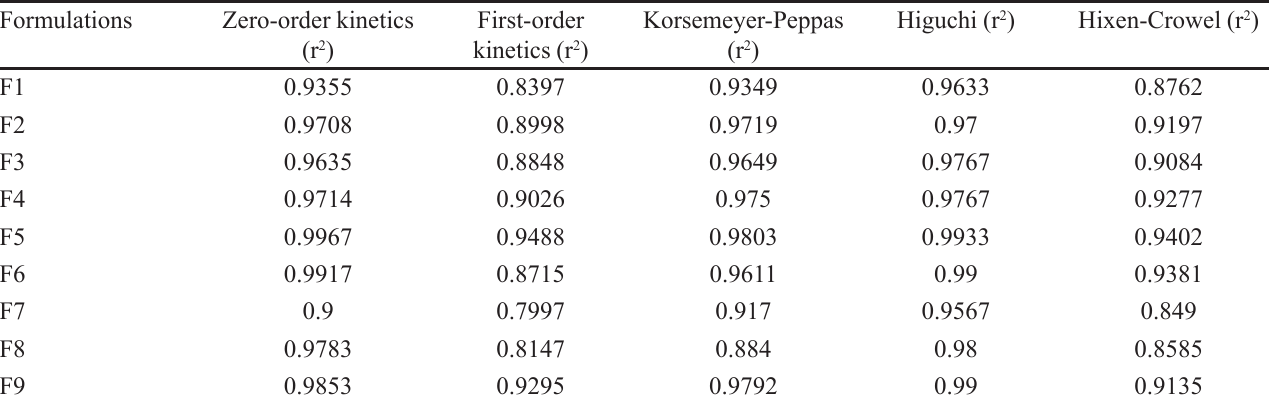
TABLE VI - Kinetic models showing drug release pattern of F1-F9 formulations Formulations